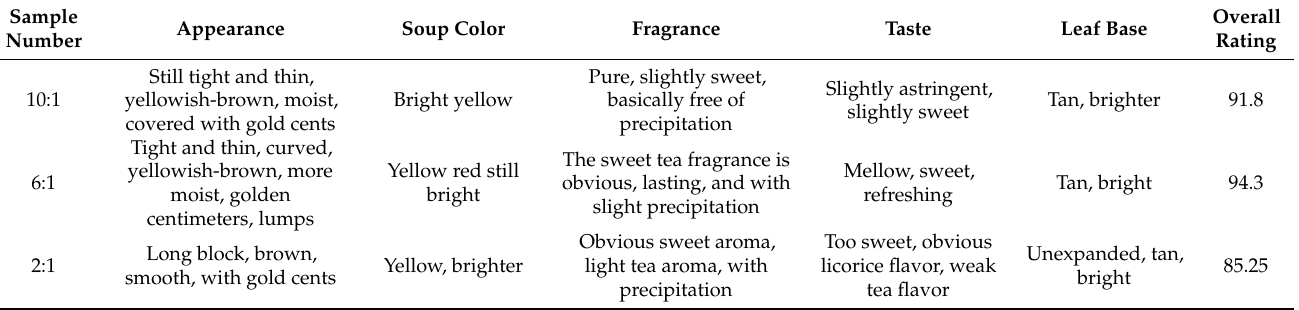
Table 2. Univariate test